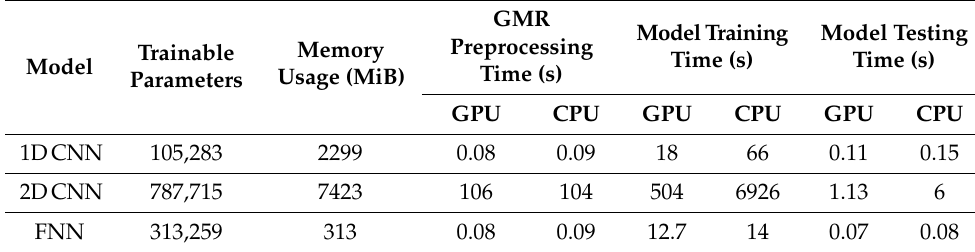
Table 1. Comparison of computing time and resources of the three neural network models.